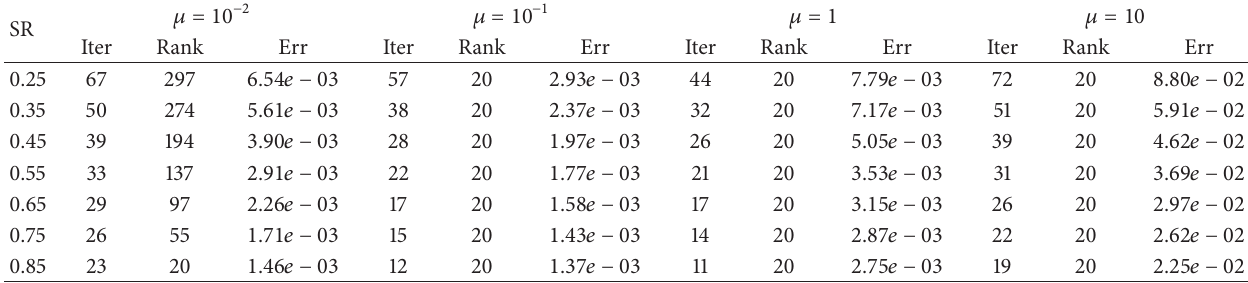
Table 1: Numerical results of different values of 𝜇 ( 𝑛 = 2000 , 𝑟 = 20 , 𝜎 = 0.01 ).